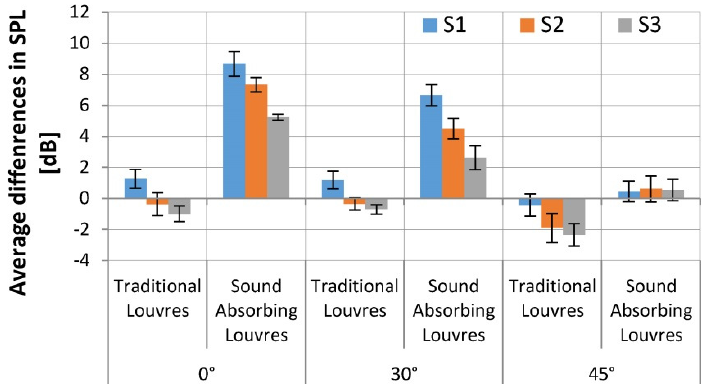
Figure 10. Average differences in Sound Pressure Levels (Insertion Loss in dB) due to the presence of the traditional louvres compared to the sound absorbing louvres. The bars in the figure are listed in function of the source positions used for the measurements (S1, S2, and S3). Error bars reports the doubled standard deviations for each average.